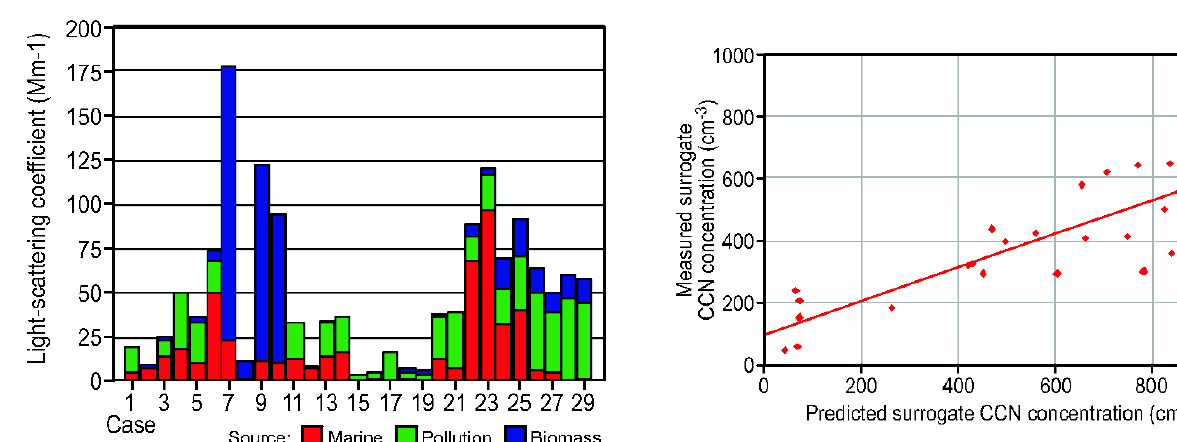
Fig. 10. Source contributions to the aerosol light-scattering coeffi- cient ( σ sp ) for each of the four sources to each of the samples taken Figure 11. Comparison via linear regression of the measured surrogate CCN(0.3%) during the CARMA II study. The samples shown were taken con- concentration with that predicted by the PMF model for the CARMA III data set. secutively between 1 and 21 July 2004.